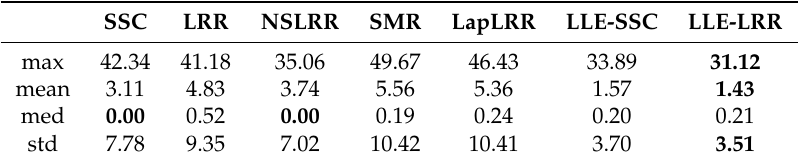
Figure 5. Some sample images from Hopkins 155 dataset. The cross marked points with different colors indicate the positions of the tracks of different motions at the current images. Table 5. Clustering results on Hopkins 155 dataset. The max value (max), mean value (mean), median value (med) and the standard deviation (std) of the errors are reported on the total 155 motion sequences. The best results are in bold